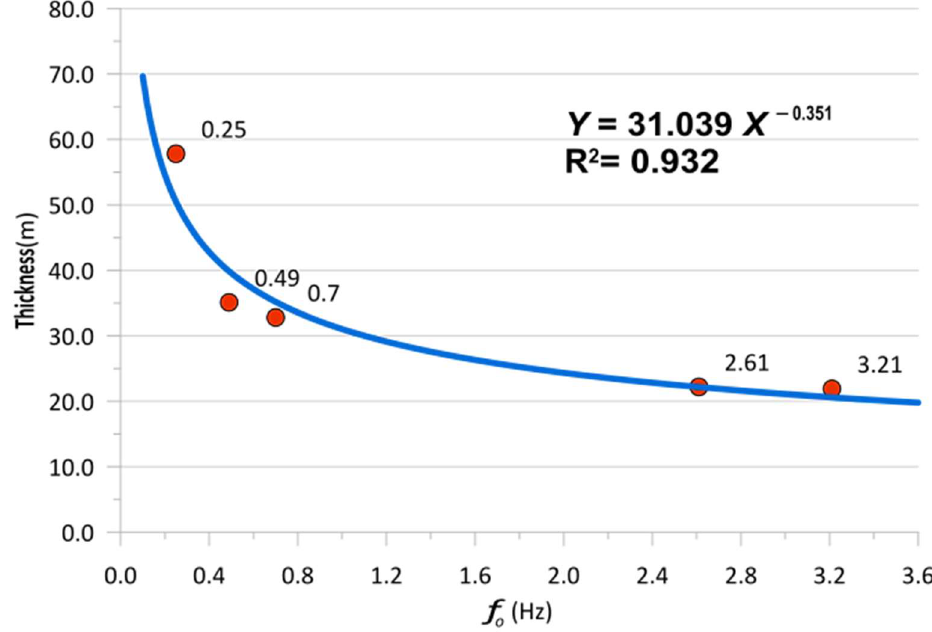
Figure 8. Empirical correlation established between VES (sediment thickness) and HVSR (frequen- cies) surveys.